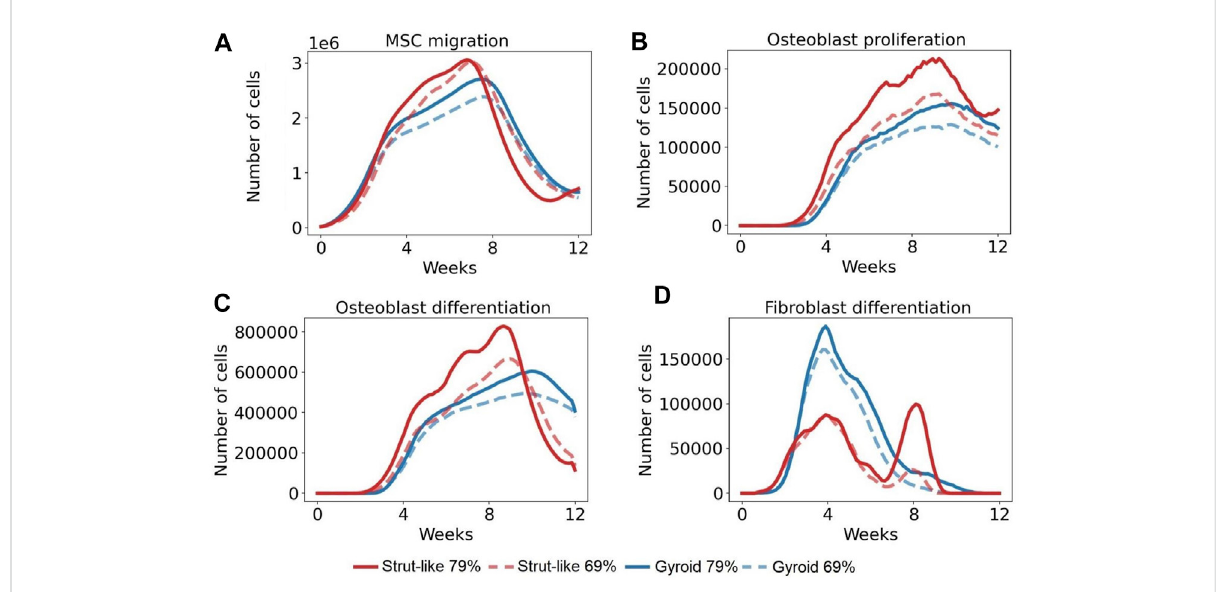
FIGURE 5 The number of the total cells per day across time in several cellular activities. (A) : Total number of MSCs that migrated per day in 12 weeks (B) : Total number of osteoblasts that proliferated per day in 12 weeks. (C) : Total number of MSCs that differentiated into osteoblasts per day in 12 weeks (D) : Total number MSCs that differentiated into fi broblasts per day in 12